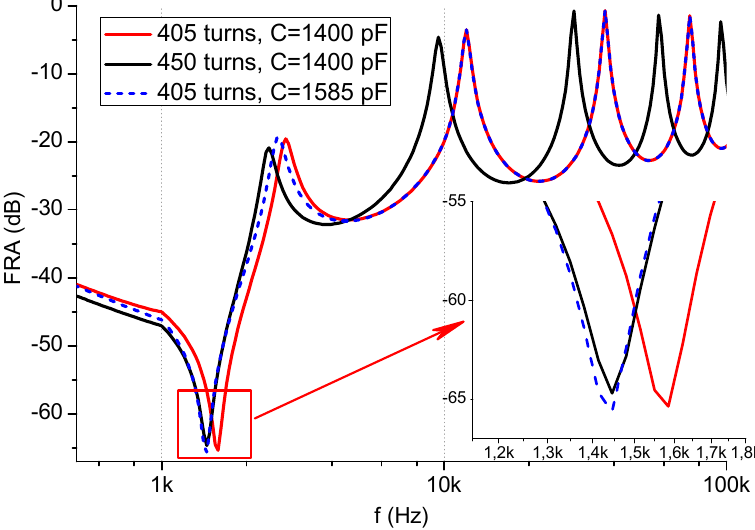
Figure 7. FR modeling for two positions of the tap changer for 405 and 450 turns, and for 405 turns with bushing capacitance